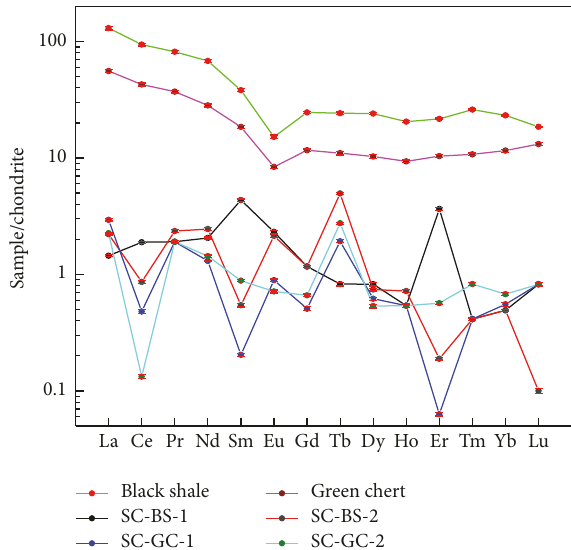
Figure 4: Chondrite-normalized REE patterns of the concretions and surrounding rocks in the Xiamaling Formation. SC-BS and SC-GC mean the silicified concretions in the black shales and green cherts, respectively. The contents of REEs of chondrite were referenced from